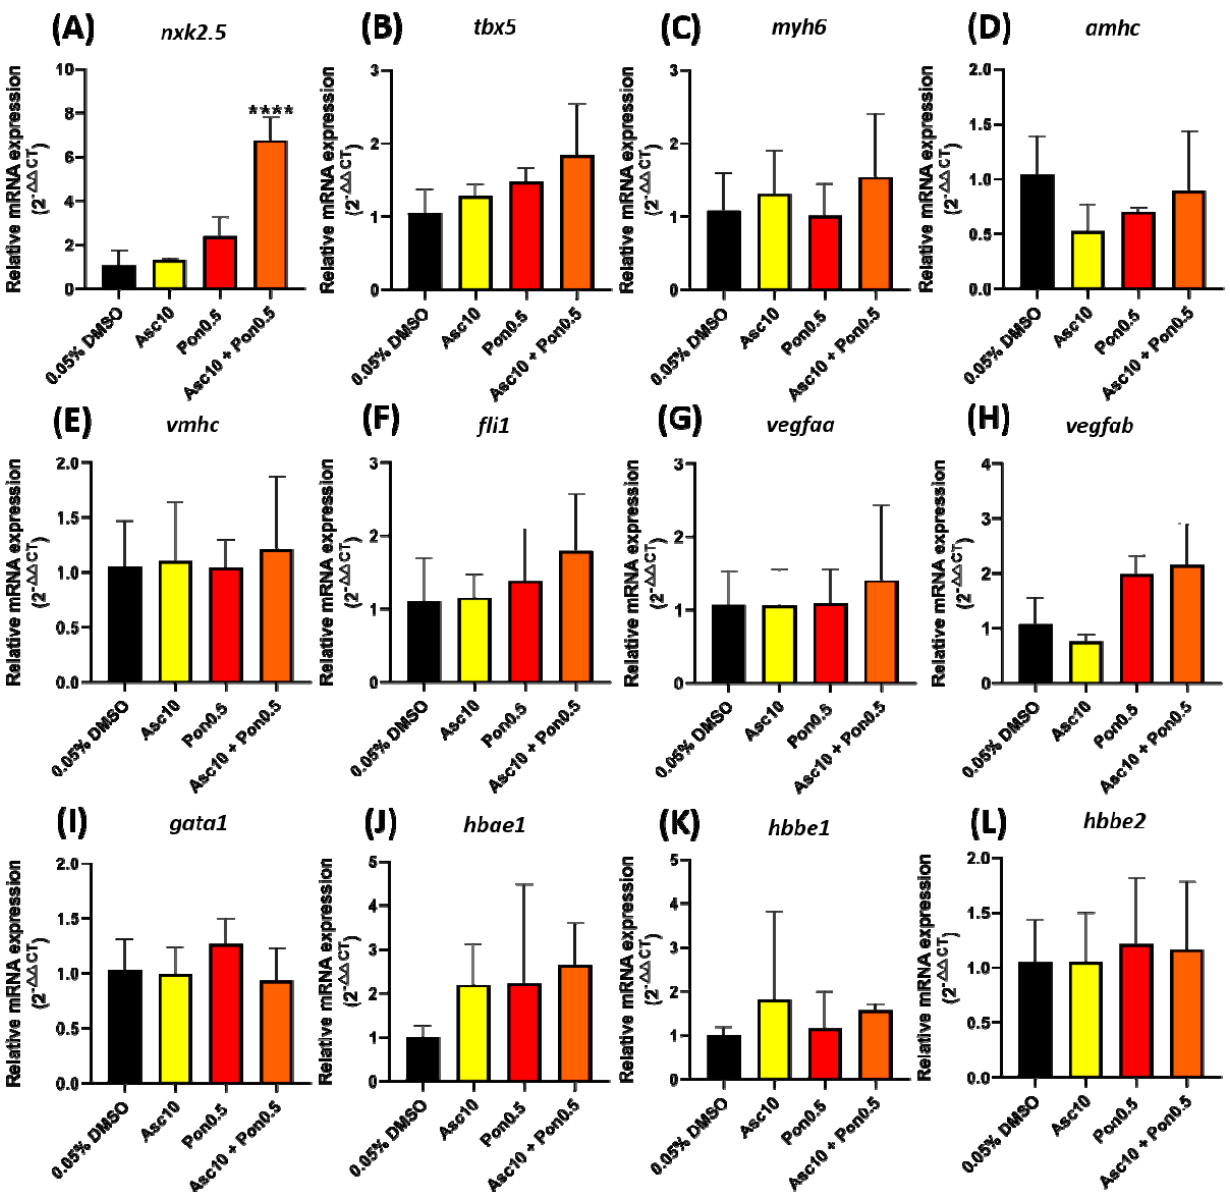
Figure 7. Relative mRNA level of cardiovascular-related genes in zebrafish after exposure to ASC, PON, and combining both compounds. Some molecular makers associated with cardiac development ( A – E ), vascular development ( F – H ), and red blood cell development ( I – L ) were tested. The value was expressed as mean ± standard deviation, and the statistical difference was calculated using ordinary one-way ANOVA with Dunnet multiple comparison test. (**** p < 0.0001).